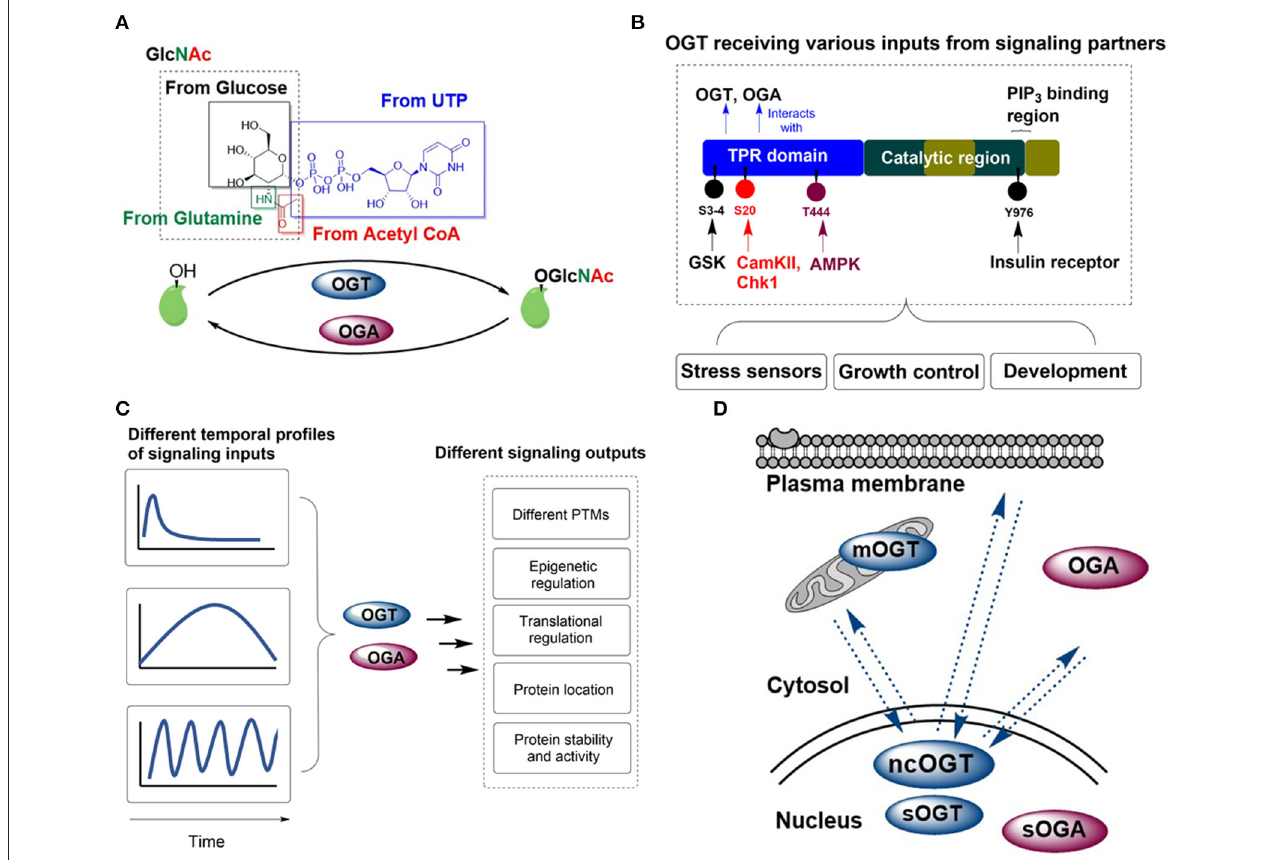
FIGURE 1 | OGT/OGA enzyme pair acts as an integrator for cellular signaling. (A) OGT and OGA catalyze the addition and removal of O-GlcNAc on proteins, respectively. The availability of UDP-GlcNAc, the product of amino acid, carbohydrate, fatty acid, nucleotide and energy metabolism, is crucial for OGT function. (B) OGT can be phosphorylated by signaling partners (such as AMPK, CamKII, Chk1, GSK, and the insulin receptor), which integrates various inputs and results in O-GlcNAcylation of protein substrates involved in diverse biological responses. (C) Temporal control is critical for O-GlcNAcylation of protein subtrates, where OGT/OGA activity is responsive to signaling input changes. (D) A unique feature of O-GlcNAcylation is the ability of OGT to shuffle in and out of the nucleus. OGT and OGA isoforms are present in the cytosolic, nuclear and mitochondrial space, whereby the spatial control of signaling can be achieved